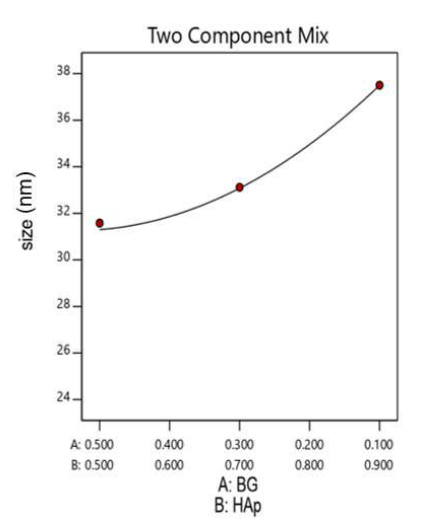
Figure 6. Effect of HAp/BG composite mixture components on HAp crystal size.